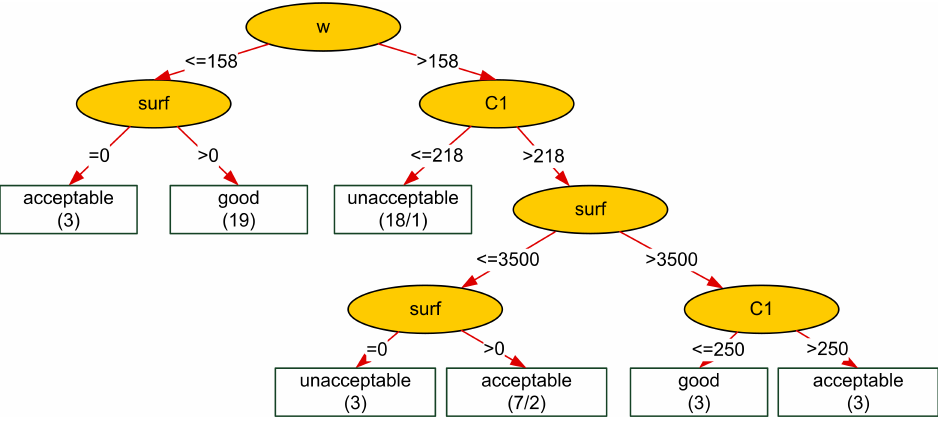
Figure 1. The decision tree for resistance to chloride penetration generated by the J48